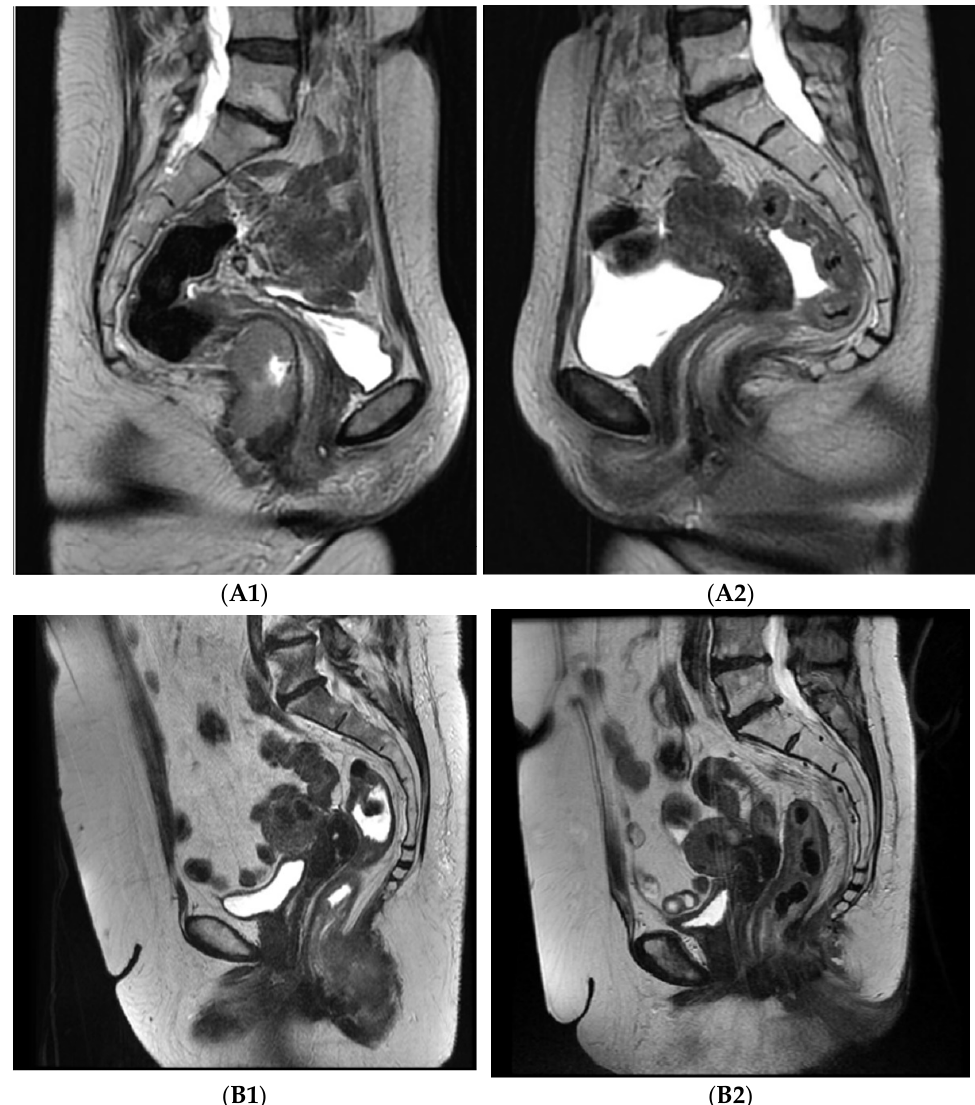
Figure 1. Axial T2 MRI images pre- and post-treatment: A —46 years old female, stage T3N0M0, ( A1 ) pre-treatment, ( A2 ) 8 weeks post-treatment, complete regression; B —62 years old female, stage T3N0M0, ( B1 ) pre-treatment, ( B2 ) 8 weeks post-treatment, partial